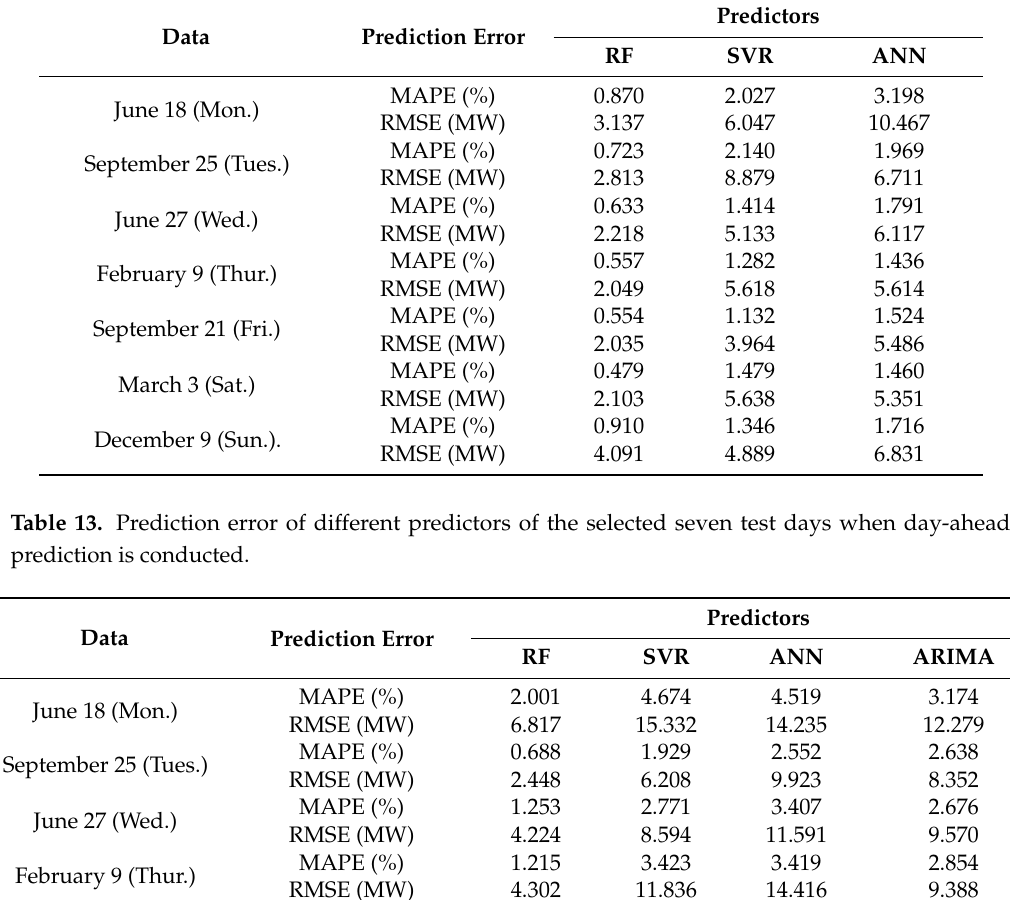
June 27 (Wed.) February 9